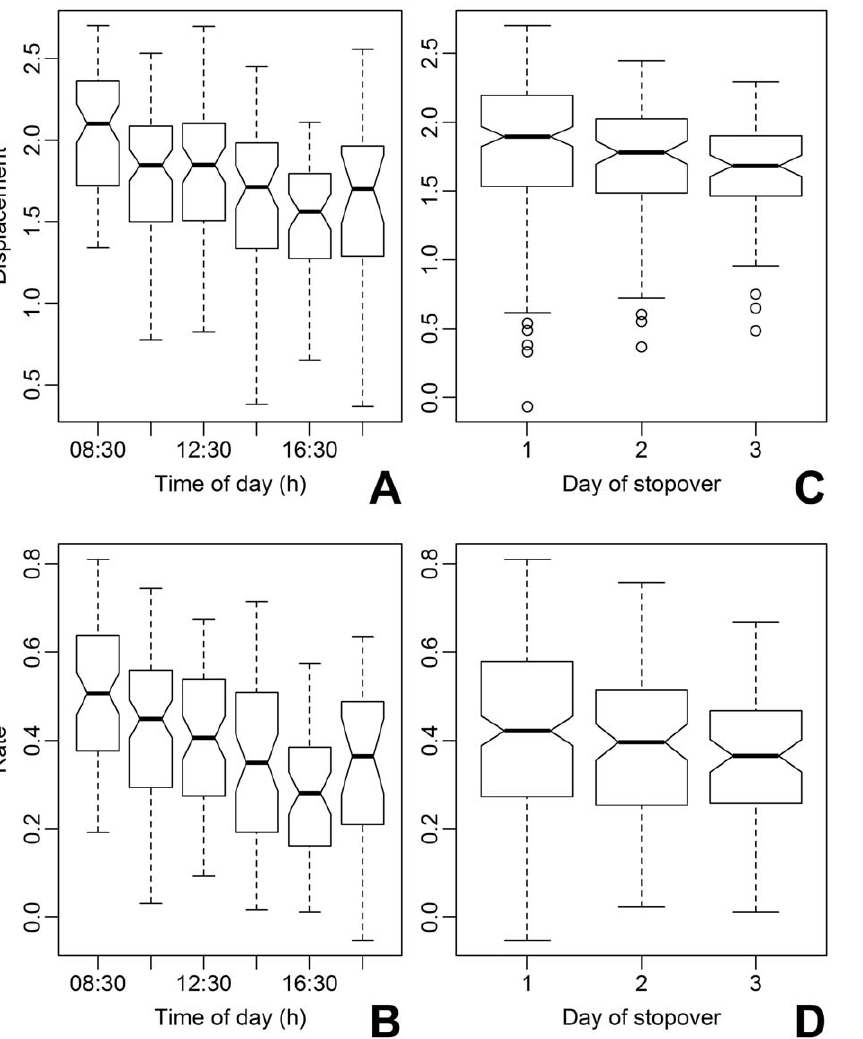
Figure 3. Model fitted movement rate and displacement distance of migratory red-eyed vireos in relation to hour of the day and day of stopover. Fitted values were extracted from a mixed model with seven fixed effects and the individual bird as a random component. Response variables were the log transformed linear displacement distance (m, A and C) and movement rate (m min 2 1 , B and D) during two hour increments throughout the first three days of stopover. Box plot whiskers depict the minimum and maximum values and around the median, indicated by the bold line. Medians differ between factors when notched areas do not overlap.